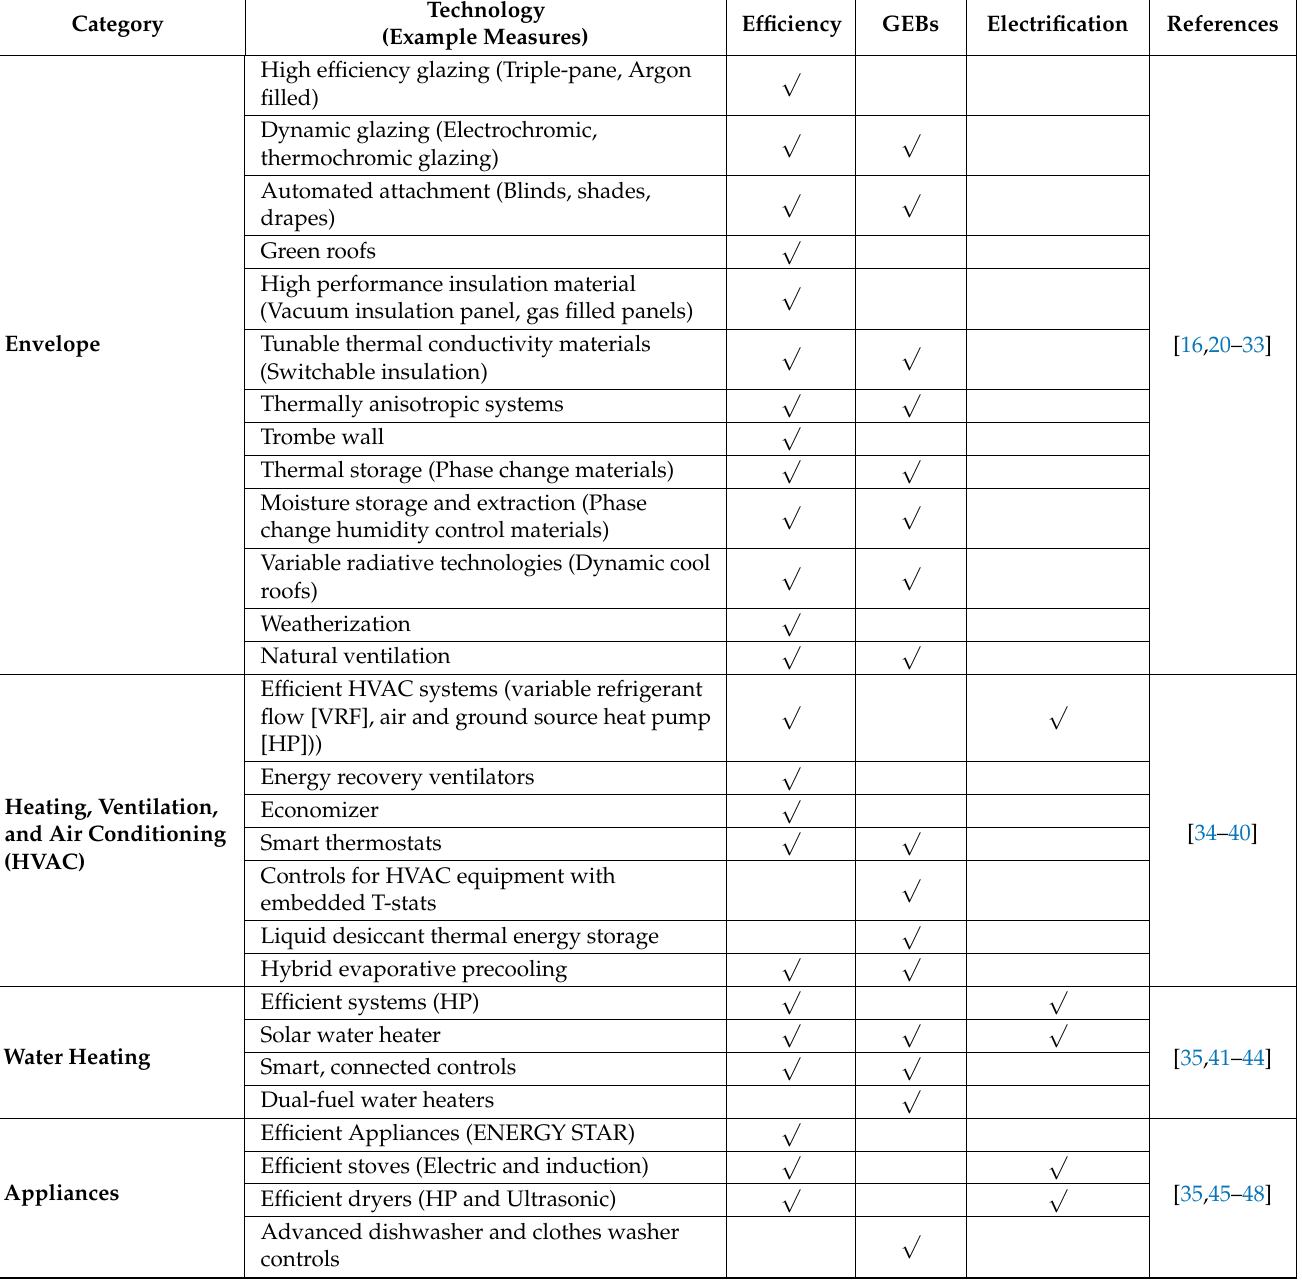
Table 1. Summary of reported technologies suitable for energy efficiency, GEBs, and electrification